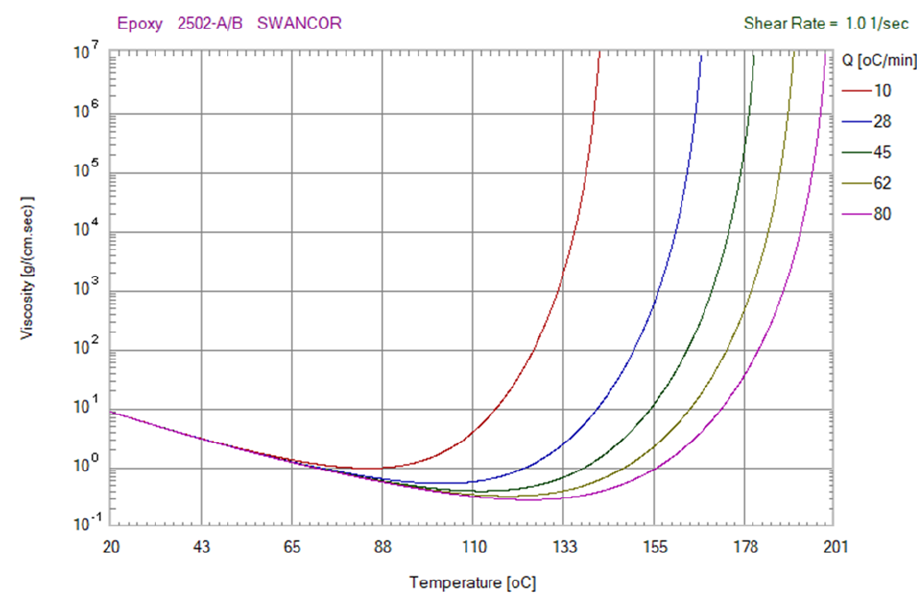
Figure 4. Viscosity as a function of the temperature of the epoxy molding material.